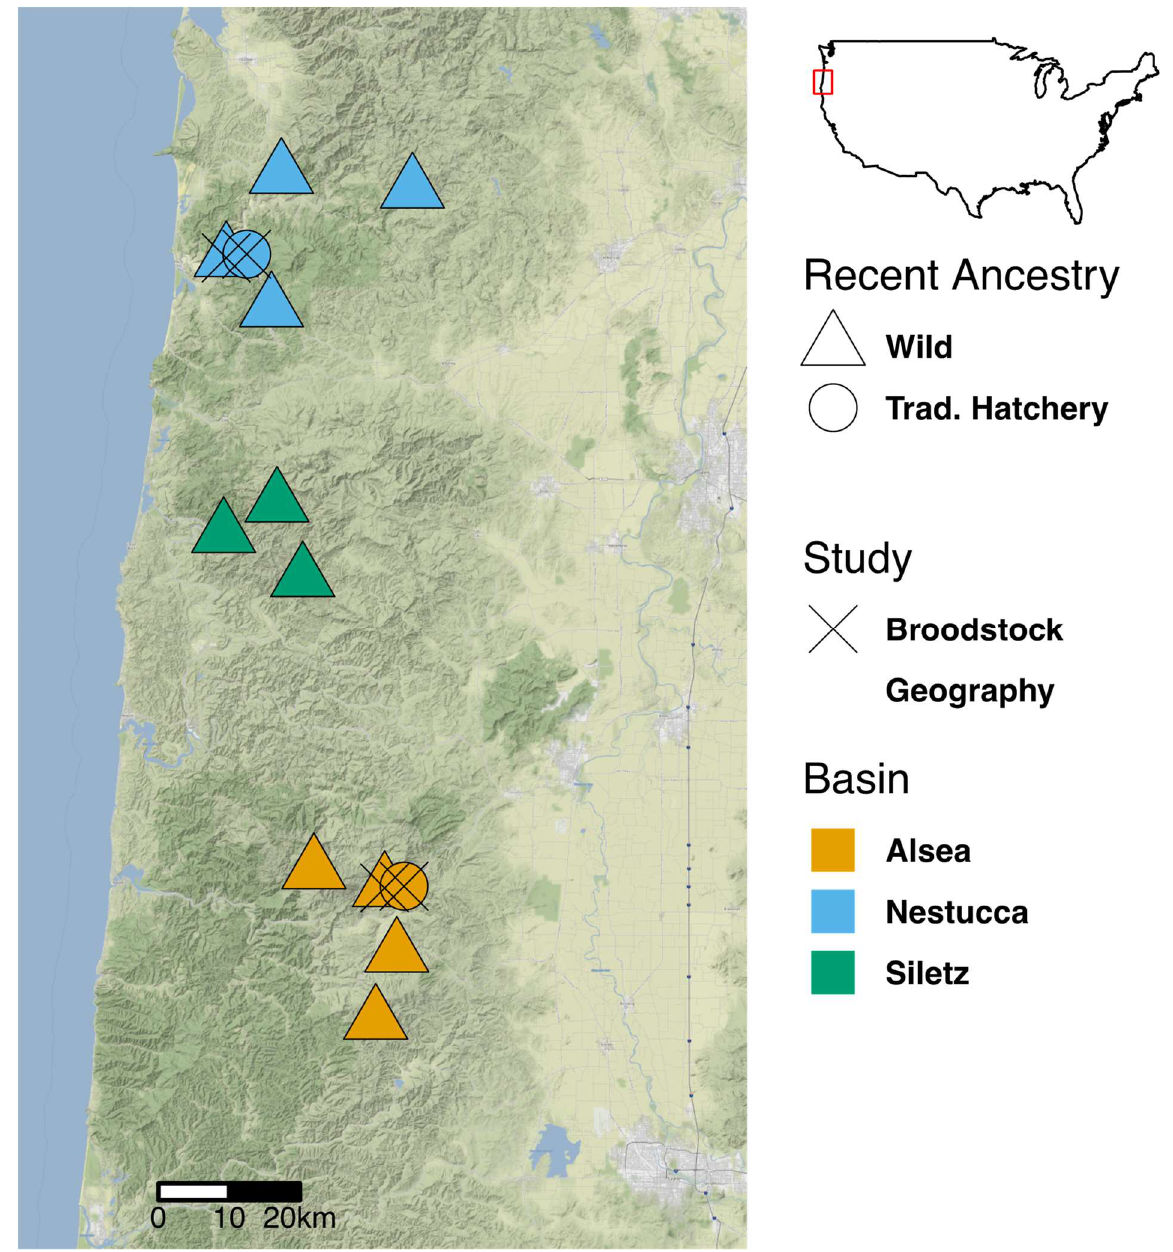
Figure 1. A map displaying sampling locations of wild steelhead intestinal samples. This is an image of the western Oregon coast between Portland, OR and Eugene, OR. Point shape, color, and inclusion of an “X” indicate recent ancestry, study origin, and river basin origin, respectively. The Oregon coast is located at the position of the red box on the border of the United States. Nestucca River basin samples are from the north sites in blue, Siletz River basin samples from the middle sites in green, and Alsea River basin samples from the southern sites in orange.